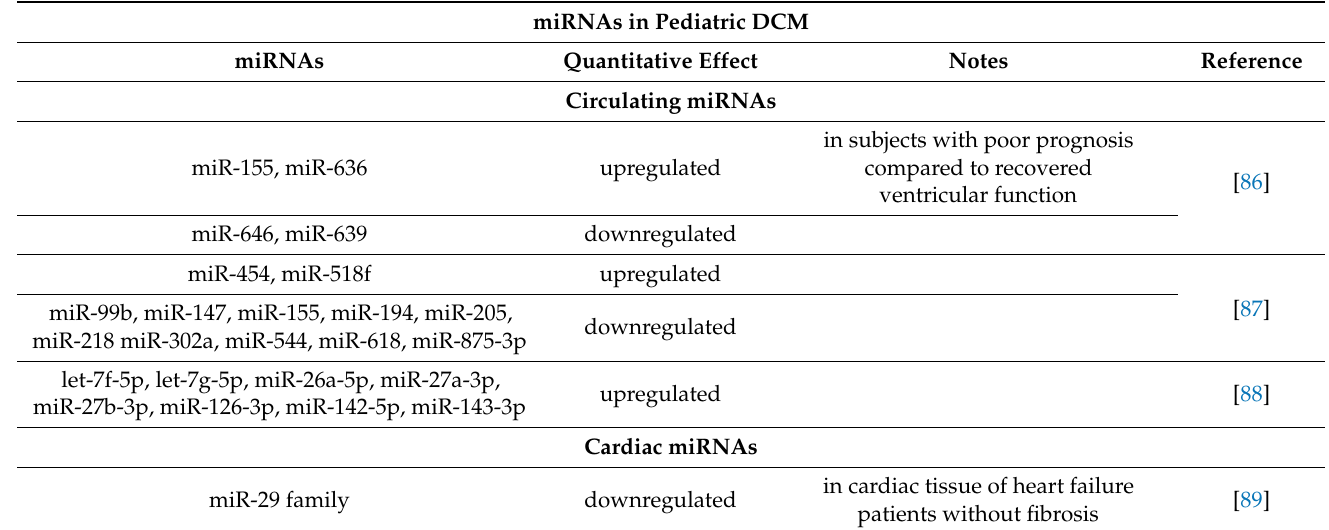
Table 4. Summary of miRNAs potentially involved in pediatric